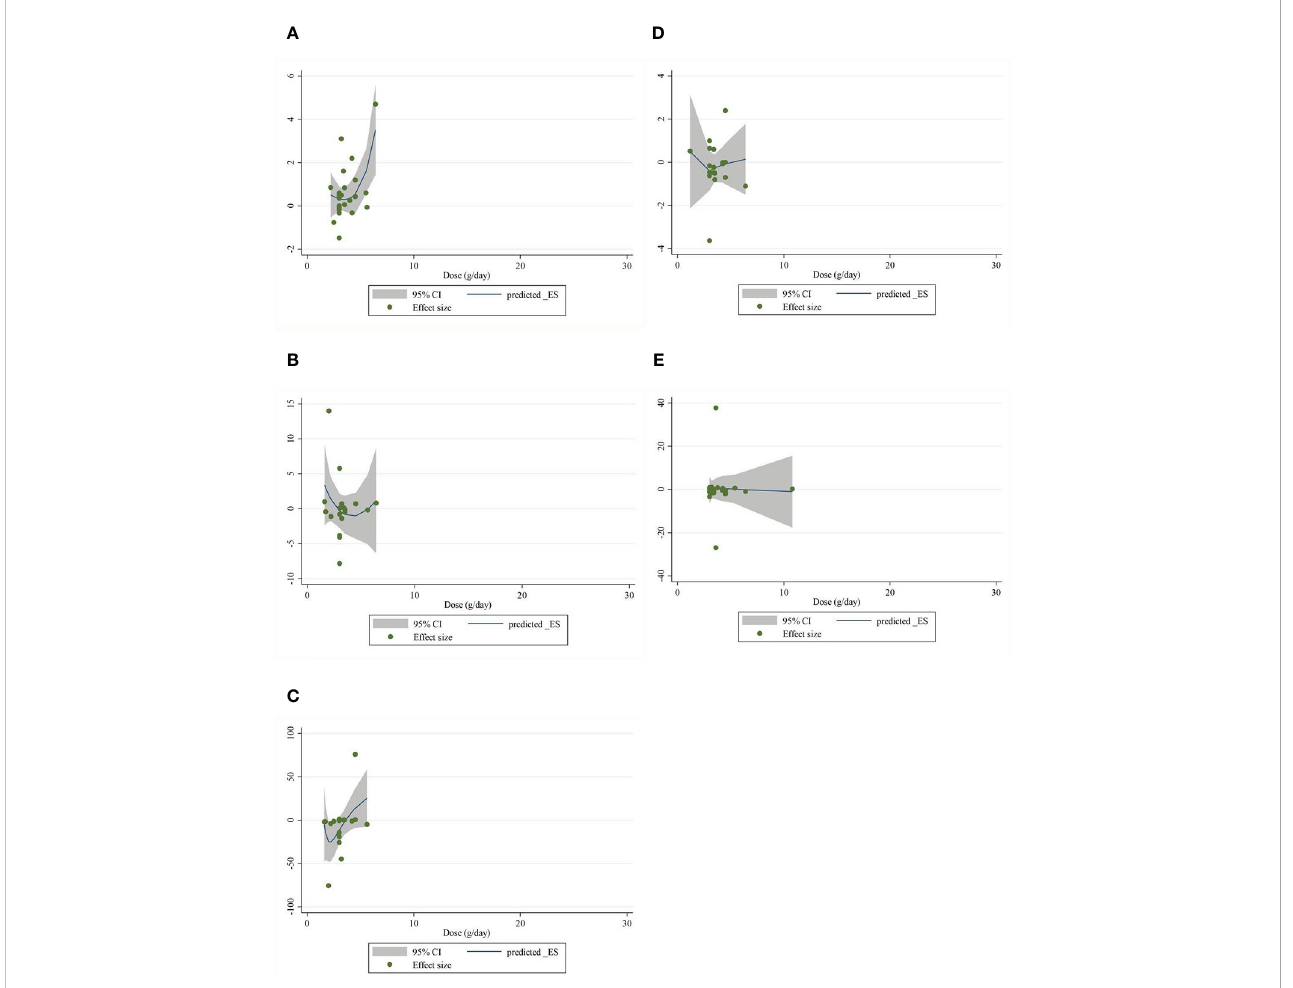
FIGURE 4 Nonlinear dose – response analysis on the effects of the CLA dosage (mg/day) on (A) CRP (mg/L), (B) IL-6 (pg/ml), (C) TNF- a (ng/ml), (D) adiponectin (µg/ ml), and (E) leptin (ng/ml). Horizontal lines represent 95% CIs. Diamonds represent pooled estimates from random-effects analysis. WMD, weighted mean difference; CI, con fi dence interval; CLA, conjugated linoleic acid; CRP, C-reactive protein; IL-6, interleukin 6; TNF- a , tumor necrosis